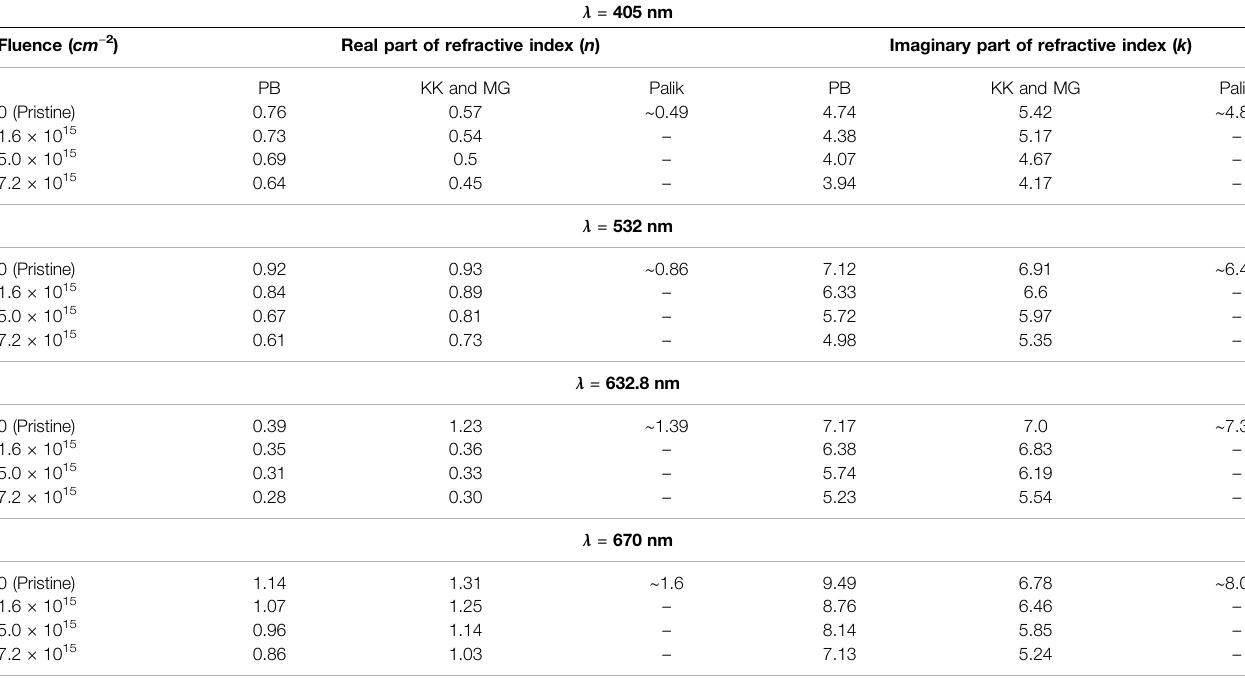
TABLE 2 | Optical constants of aluminum MTF where PB: pseudo- Brewster angle technique, KK: Kramers-Kronig technique, MG: Maxwell-Garnett technique, Palik [26]